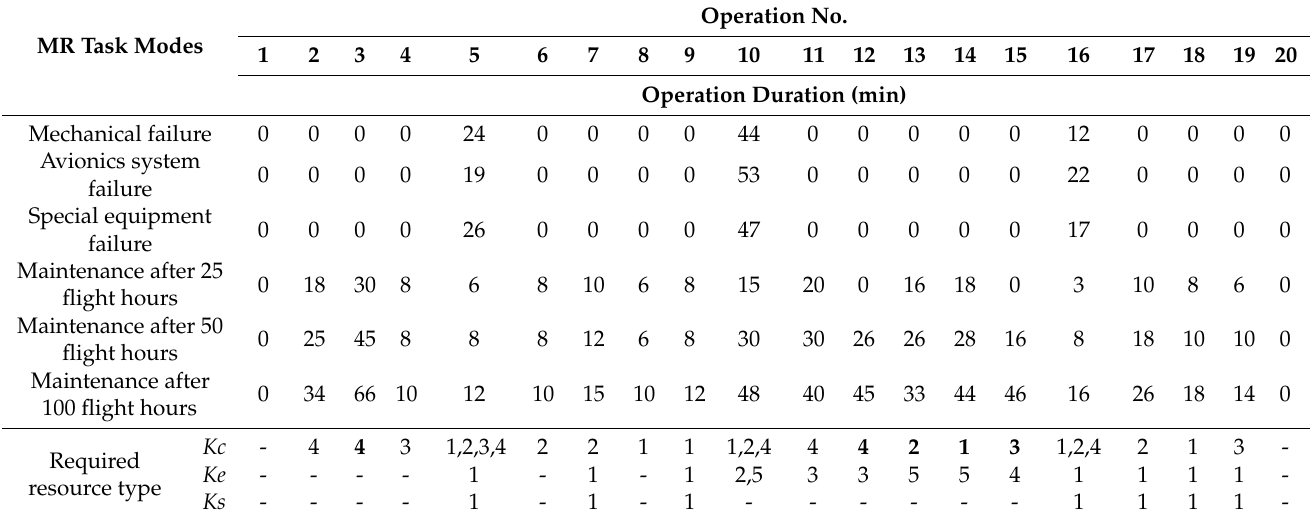
Table 4. Duration and requirements of maintenance and repair operations for carrier-based